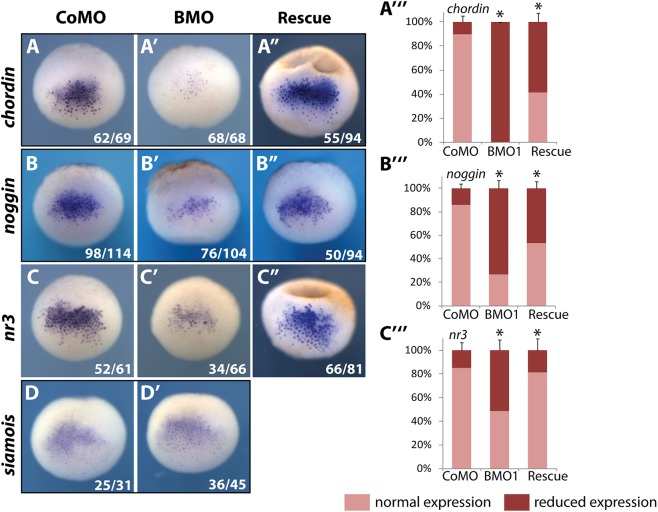
Brg1 protein knockdown diminishes gene expression in the BCNE center.Pictures show dorsal views of whole mount RNA in situ hybridization (WMISH) at late blastulae (NF9, X. laevis) with gene expression patterns representative for the experimental condition. Injection conditions are indicated on top: CoMO (60ng/embryo), BMO1 (60ng/embryo), Rescue (BMO1 plus hBRG1 mRNA [1ng/embryo]). Reagents were radially injected into the animal hemisphere. The mRNA expression patterns of chordin, noggin and nodal-related 3 (nr3) in control morphants (panels A-C) were reduced in BMO1 morphants (panels A’–C’), but restored by coinjection of human brg1 mRNA (panels A” –C”). The graphs (A”‘–C”‘) depict phenotypic penetrance (n = 3–4 experiments/condition). The expression of siamois was not affected by BMO1 (panels D + D’, n = 2 experiments/gene).